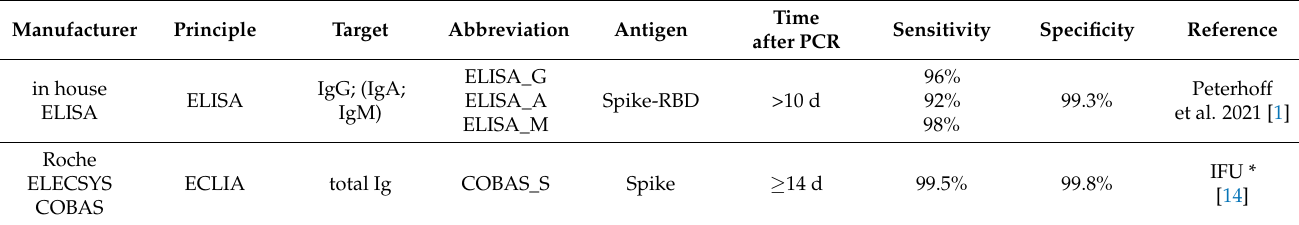
Table 1. Applied antibody tests with manufacturer, test principle, test target, test strategy, antigen, cutoff, sensitivity and specificity as provided by the